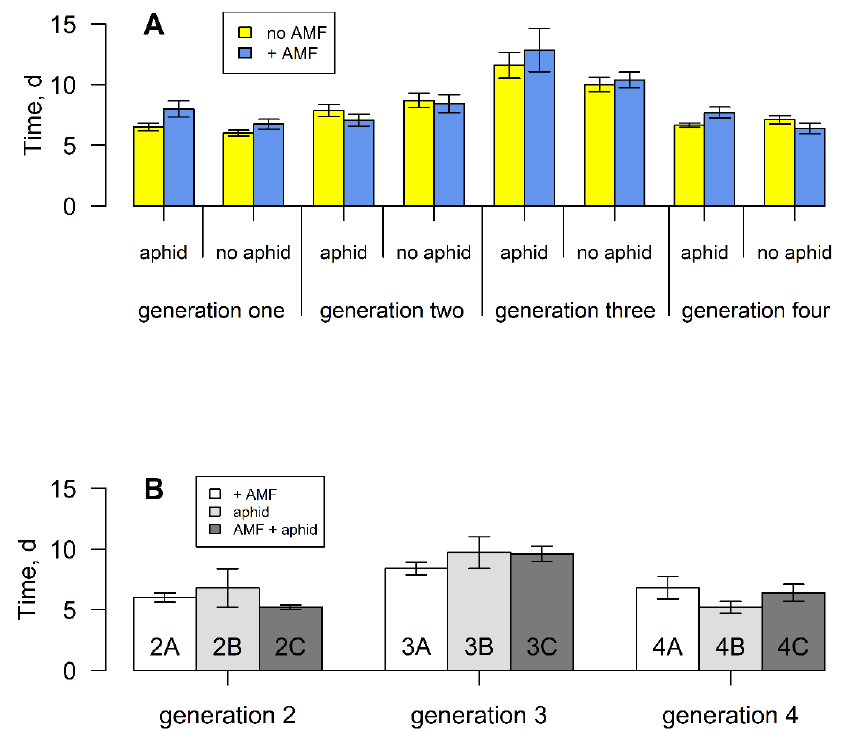
Figure 1. ( A ) Mean seed germination time of S. vulgaris grown with or without arbuscular mycorrhizal fungi and aphids for four successive generations. Vertical lines represent ± one standard error.